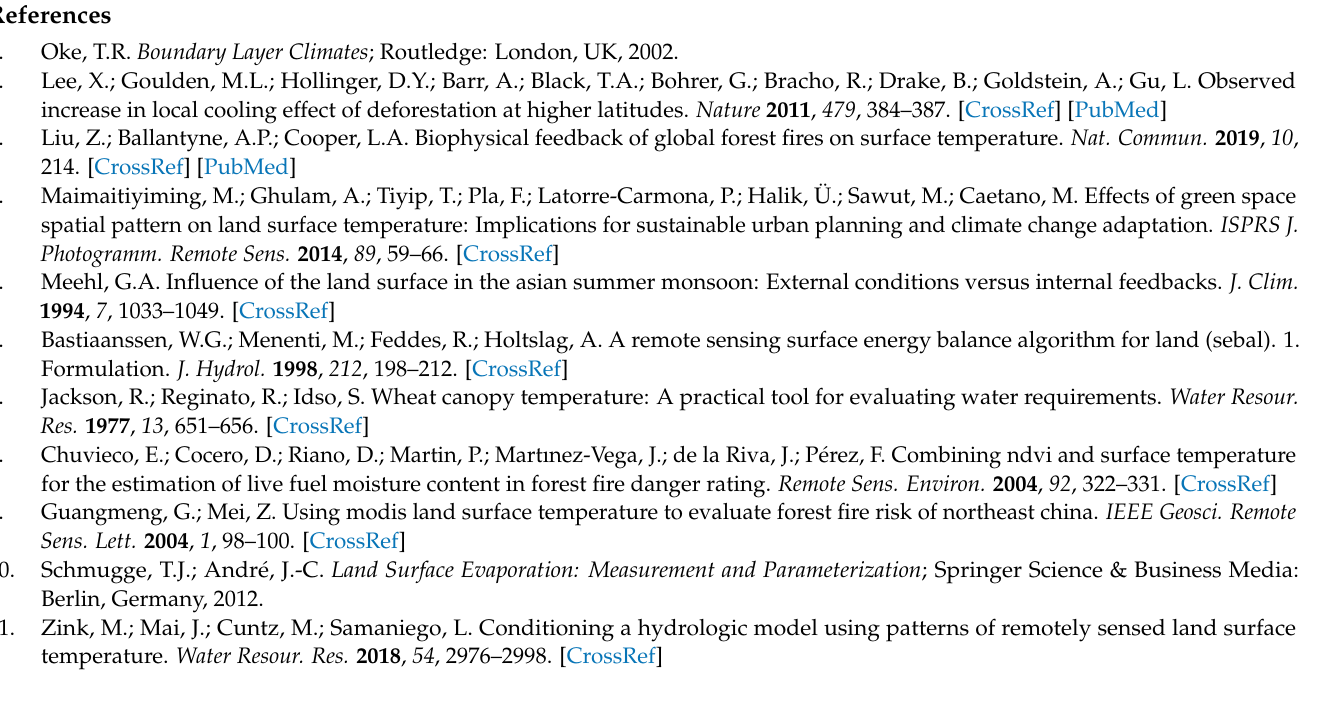
predicted patch-level LST, Figure S3: Training and validation losses for each target date, Figure S4: Ensemble mean training and validation losses, S5: Sharpening results for 4 May 2017, Figure S6: Correlation plot of sharpening results for 4 May 2017, Figure S7: Sharpening results for 29 July 2019, Figure S8: Correlation plot of sharpening results for 29 July 2019, Figure S9: Sharpening results for 28 November 2017, Figure S10: Correlation plot of sharpening results for 28 November 2017, Figure S11: Patch-scale and pixel-scale error for 4 May 2017, Figure S12: Patch-scale and pixel-scale error for 18 June 2016, Figure S13: Patch-scale and pixel-scale error for 30 September 2013, Figure S14: Sharpening residual of the area with significant pixel-scale error, Figure S15: Satellite map of the area with significant pixel-scale error, Figure S16: Locations where significant biases result from land cover changes, Figure S17: Residuals of pixel-scale variations in the form of histograms, Figure S18: Validation using mobile transect data on multiple dates. Table S1: Statistics of validation for each mobile